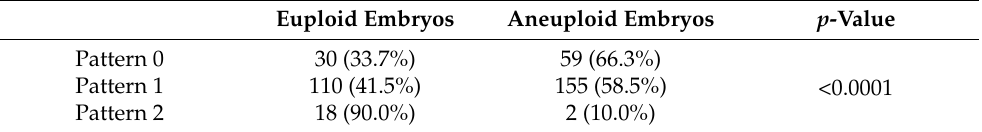
Table 2. Occurrence of the different cytoplasmic patterns of st 2 in euploid and aneuploid embryos.